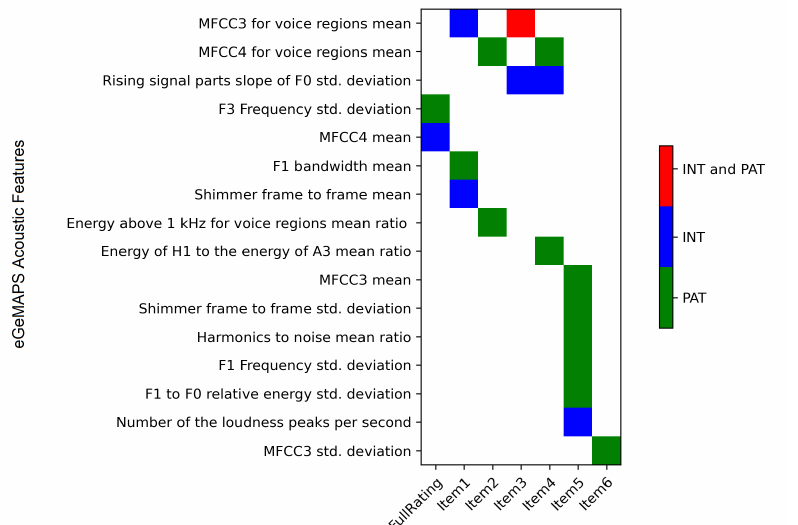
Figure 5. The best eGeMAPS features represented on the horizontal axis for predicting the full competency rating or each rating item as indicated on the vertical axis. The rating item numbers are based on the numbers in Table 4. The green blocks indicate the selected features for the patient’s segments, the blue blocks indicate the selected features for the practitioner’s segments and the red blocks indicate the selected features for the full session, including the patient’s and practitioner’s segments. (std. deviation = standard deviation, H1 = first F0 harmonic, A3 = highest harmonic in the third formant